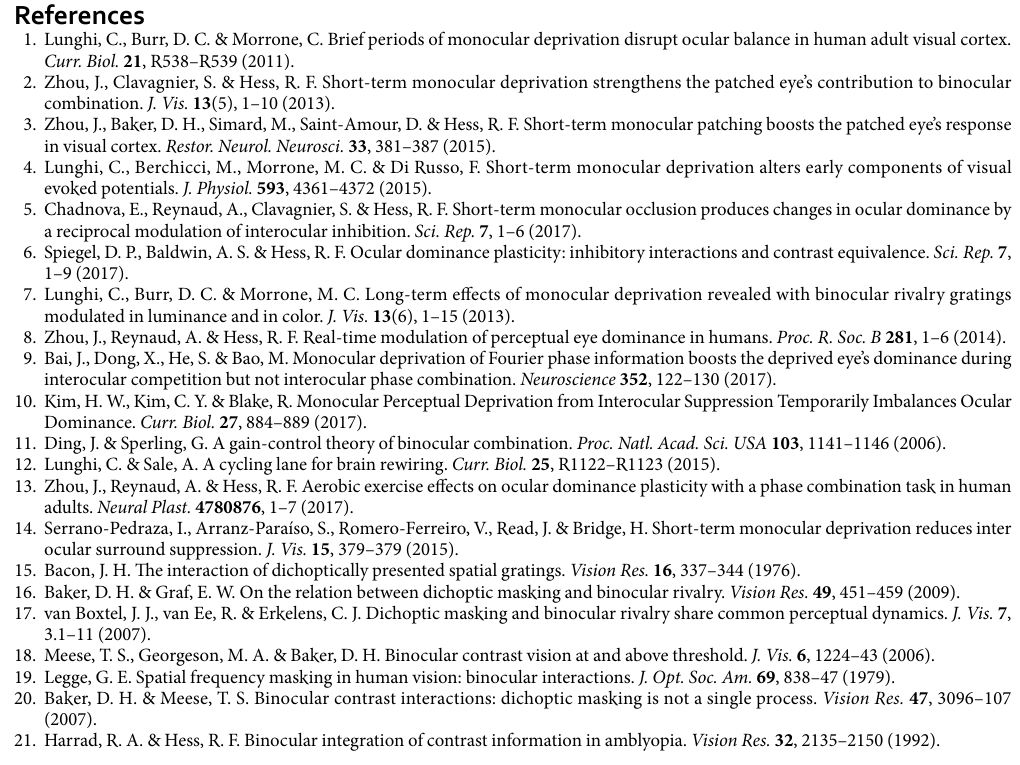
Subjects. Fourteen subjects (including one of the authors) participated in the study (Table 1). Subjects wore their optical correction appropriate to the viewing distance for the experiment. All subjects gave written informed consent. The experiments were performed in accordance with the Declaration of Helsinki, and approved by the Research Ethics Board of McGill University Health Centre. Analysis. Psychometric functions were fit by log-Quick functions in Palamedes 41 . For Figs 1 and 2 the data were collapsed over all repeats of the same condition from both testing sessions before fitting. For Fig. 3 the data from the two sessions were analysed separately. The lapse rate was fixed at 1%. Fitted psychometric function slope parameters were limited to a maximum value of β = 5. This changed the value from one of the eighty-four fits, where the original slope was very steep ( β = 57). The correlation tests were performed in Python 2.7 42 using SciPy 43 . The t-tests and ANOVA were performed in R 44 , using RStudio 45 . Data availability.